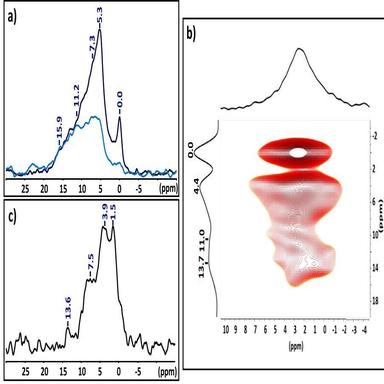
MAS NMR spectra (νr = 60 kHz) of Hu-dentin: (a) 1H/31P double cross polarization (DCP) with long (6 ms - 2 ms, black) and short (3 ms - 0.2 ms, blue) CP times. (b) 2D 1H/31P HETCOR (contact time 2 ms). (c) 1H/13C DCP (contact times 3 ms – 2 ms).